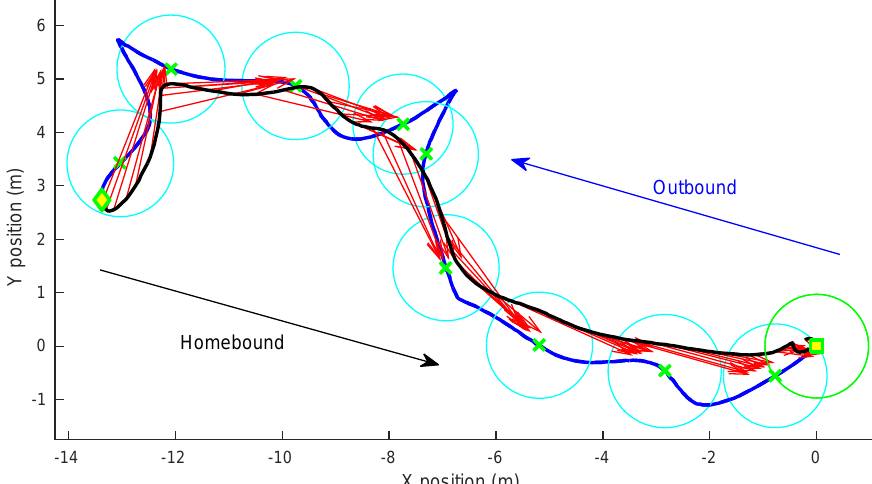
Figure 14. Route learning and long-range homing in a closed-loop flight test: the home and goal locations are represented by a square and a diamond, respectively. The exploratory journey is shown in dark blue, with green crosses indicating the snapshot waypoint locations and the corresponding catchment areas (CAs), shown in cyan. The homing path back to the home location is represented in black, with the red vectors being the homing vectors that point towards the center of each memorised CA in reverse order. Reproduced with permission from